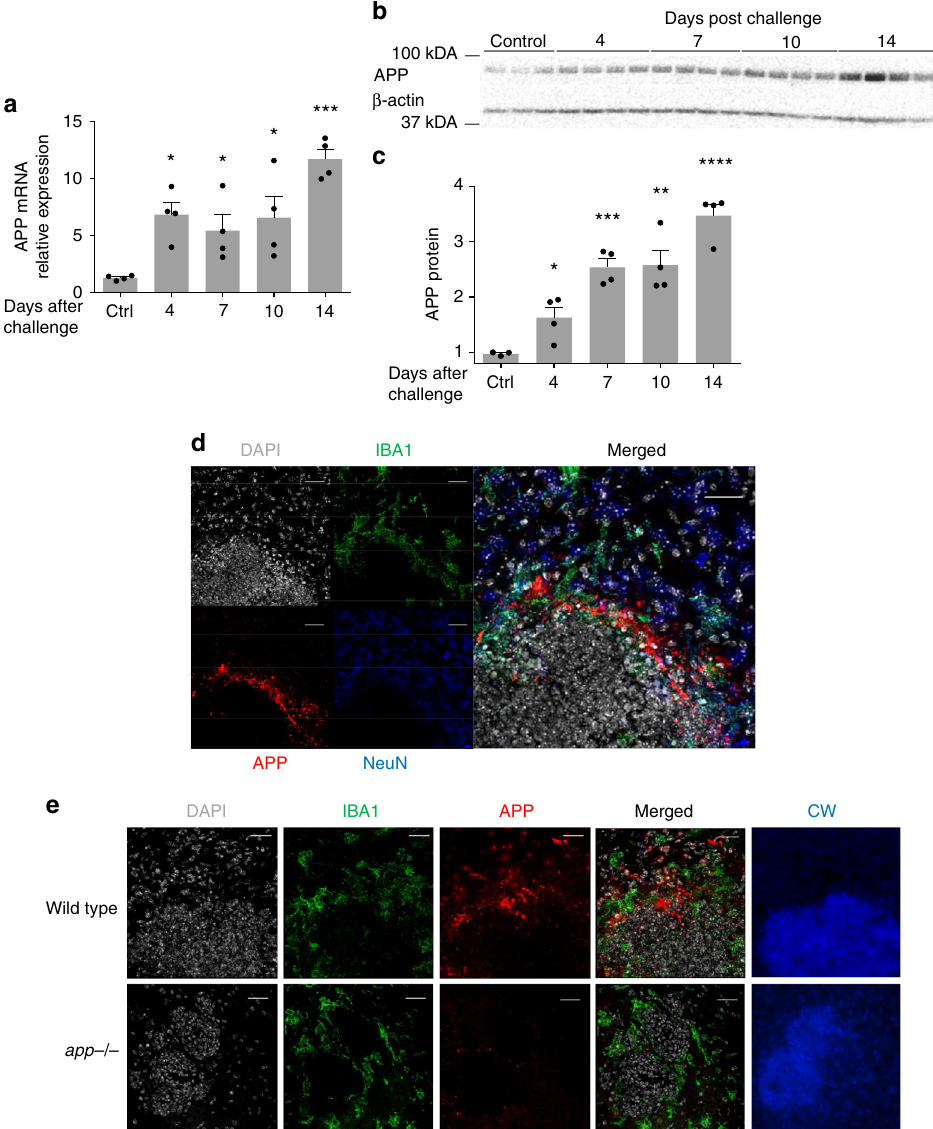
Fig. 3 C. albicans cerebritis induces upregulation of amyloid precursor protein (APP). Mice were challenged with C. albicans as in Fig. 2 and RNA and protein extracted from whole brain. a qRT-PCR was performed to quantify mRNA for APP over 14 days. b Western blot analysis of APP over the same time period. c Densitometric analysis of the western blot data. d Immuno fl uorescence images of brain from C. albicans -infected wild-type mice 4 days post i.v. challenge with C. albicans showing staining for DAPI, IBA1, APP, NeuN, and merged images. Images are centered on fungal granulomas similar to those shown in Fig. 2. e Repeat staining of fungal granulomas for DAPI, IBA1, APP, and calco fl uor white (CW) comparing wild-type to app − / − mice. ( n = 4, mean ± S.E.M, * p < 0.05, ** p < 0.01, and *** p < 0.001 using one-way ANOVA followed by Dunnett ’ s test for multiple comparison. Scale bar: 20 μ m). Data are shown